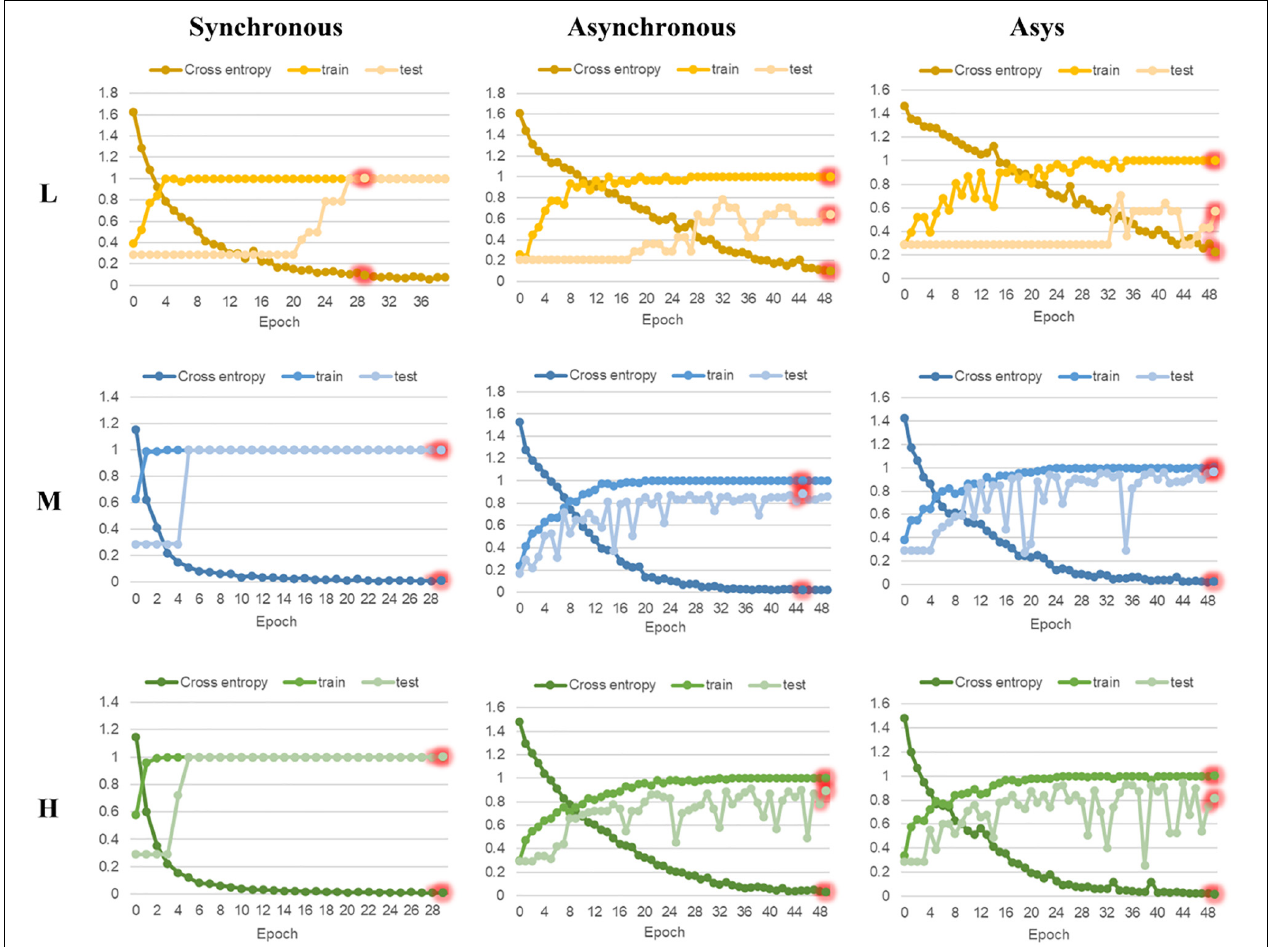
FIGURE 6 | The accuracy curves and cross-entropy cost function of ResNet models based on part data with different sample size. L, low sample size; M, medium sample size; H, high sample